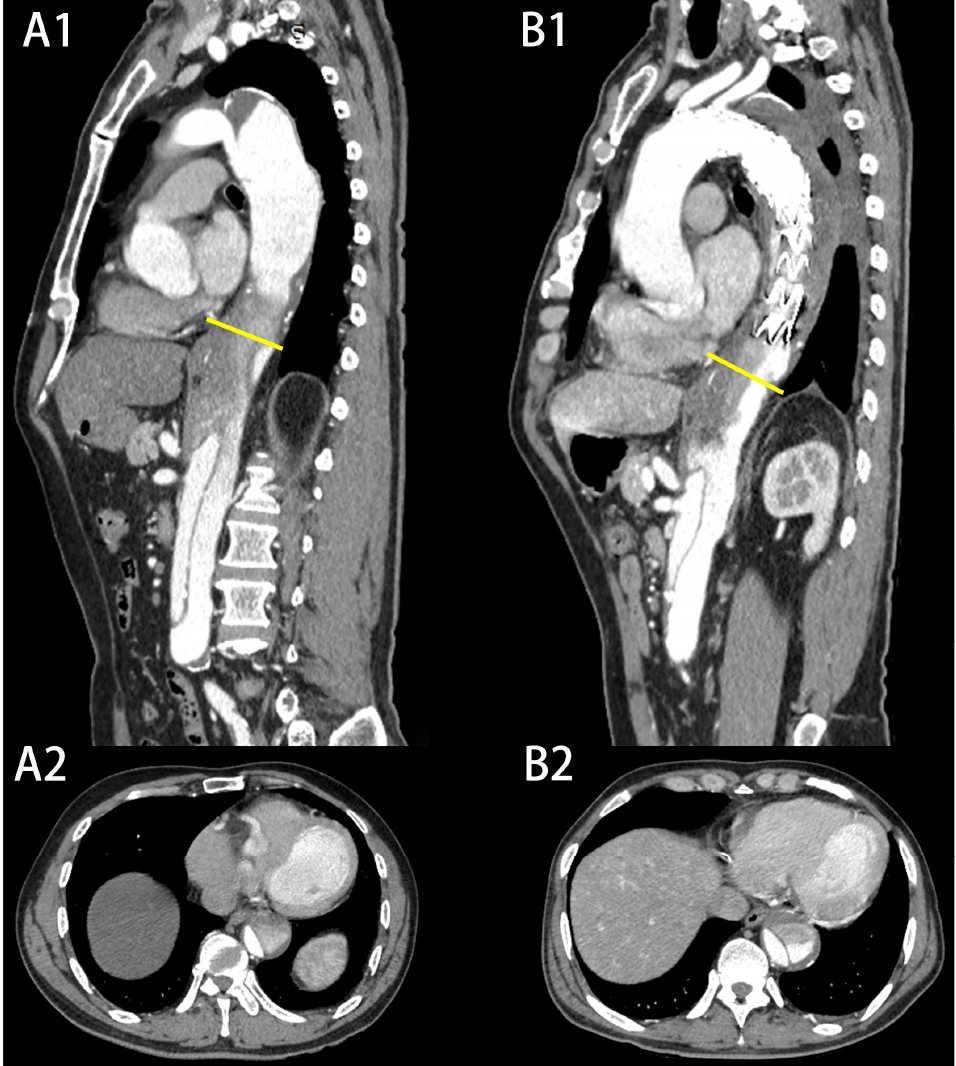
Figure 4. The state of the FL before and after TEVAR: ( A1 , A2 ) a patient with preoperative partial thrombosis of the FL, with no signi fi cant change in the state of the FL after TEVAR ( B1 , B2 ).